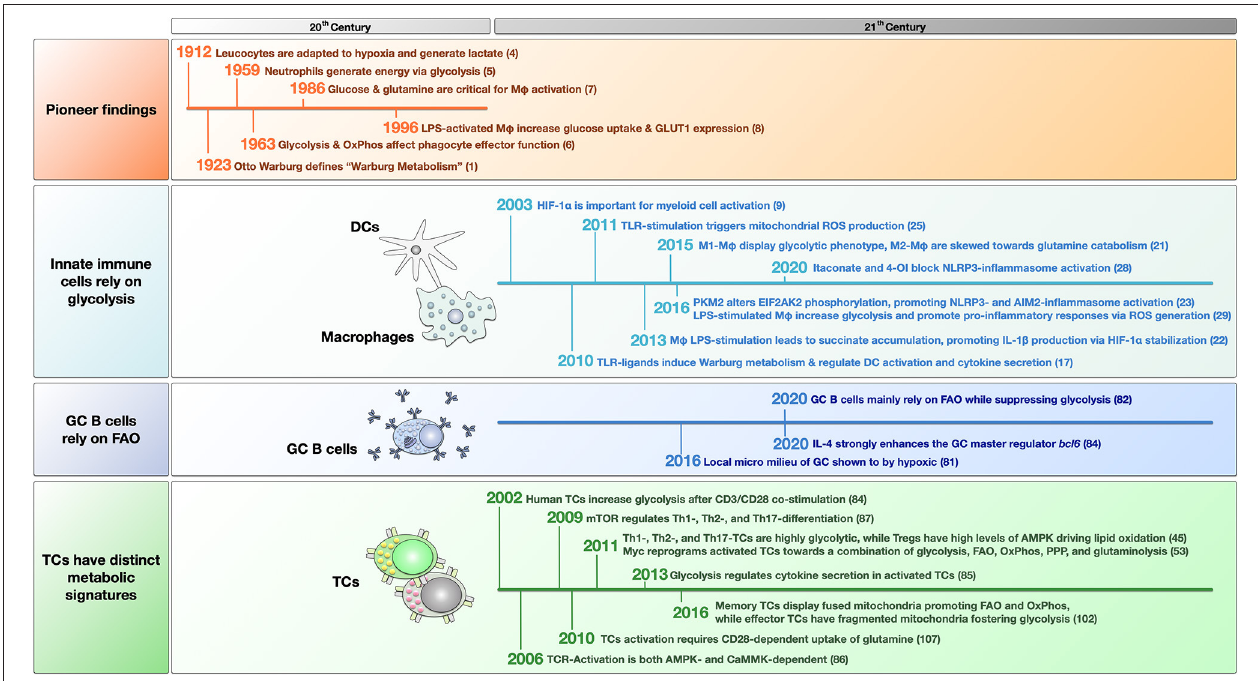
FIGURE 1 | Timeline of pioneering and breakthrough papers that have helped form the field of immune metabolism. The findings are grouped into pioneer studies in the last century, and recent findings about innate immune cells, germinal center (GC) B cells, and T cells. For more detailed information see the main text. LPS, lipopolysaccharide; OxPhos, oxidative phosphorylation; FAO, fatty acid oxidation; GLUT1, glucose transporter 1; HIF-1 α , hypoxia-inducible factor 1 alpha; TLR, “Toll” like receptor; ROS, reactive oxygen species; M ϕ , macrophage; 4-OI, 4-octyl itaconate; PKM2, pyruvate kinase isozyme M2; EIF2AK2, eukaryotic translation